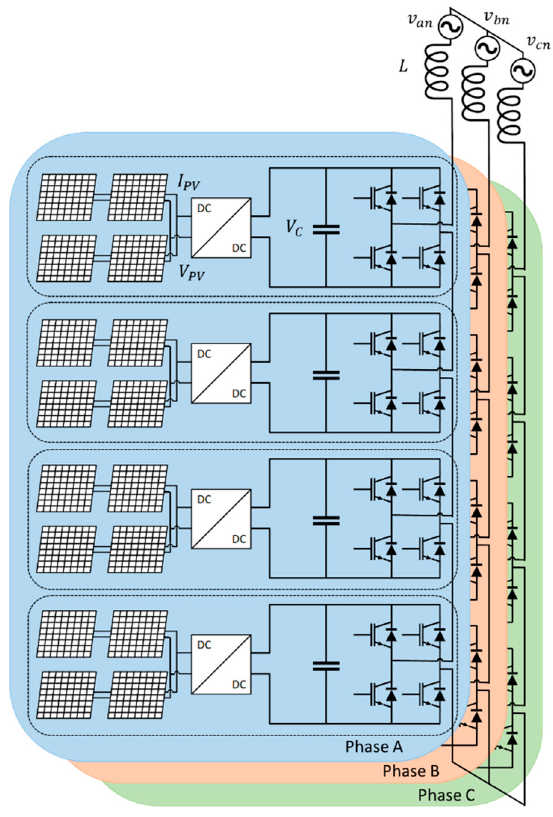
Figure 1. Grid tied CHB inverter in a photovoltaic plant.